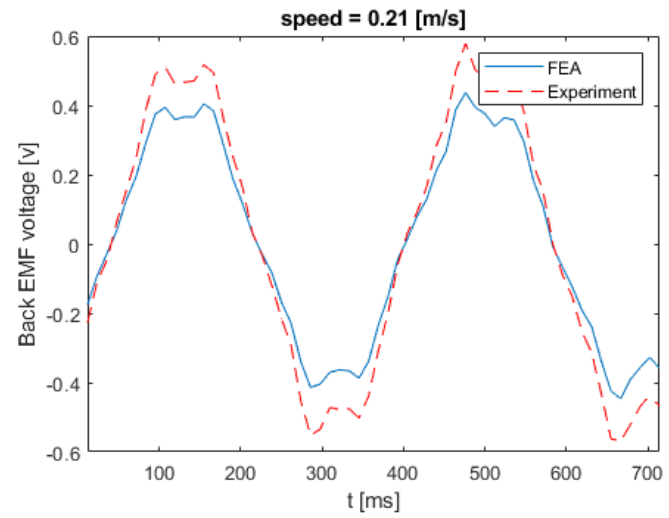
Figure 17. Back EMF voltage for linear speed of 0.21 m/s.